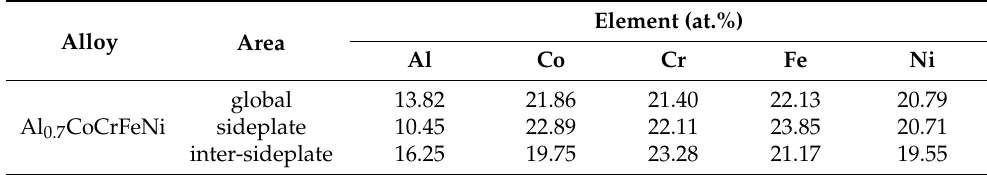
Table 2. The chemical composition of Al 0.7 CoCrFeNi high-entropy alloy.